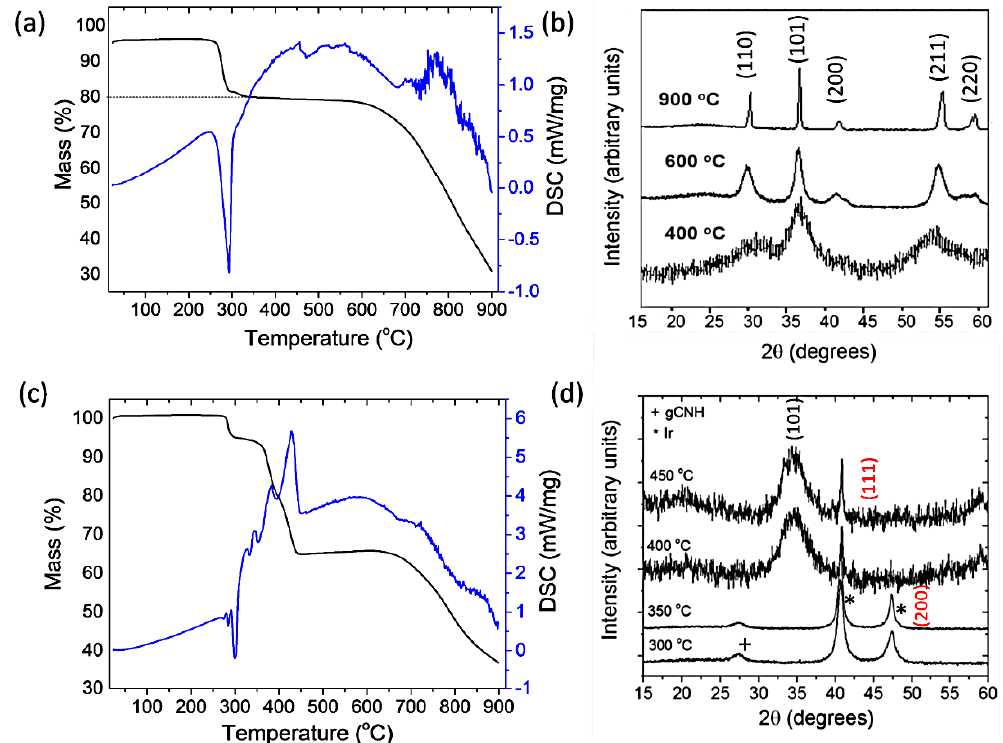
Figure 2. ( a ) TGA/DSC of the reaction between (NH 4 )Ir 2 Cl 6 and NaNO 3 conducted in air at a 5 ◦ C min − 1 heating rate; ( b ) the XRD of the IrO 2 NPs produced at 400, 600, and 900 ◦ C by the Adams’ fusion method; ( c ) the TGA/DSC of (NH 4 )Ir 2 Cl 6 , NaNO 3 , and gCNH support conducted in air at a 5 ◦ C min − 1 heating rate; ( d ) XRD of the gCNH-IrO 2 prepared at 300, 350, 400, and 450 ◦ C. Note: the NaCl formed in the reaction was washed out prior to the XRD acquisition. The weak feature for gCNH occurs at ~27 ◦ 2 θ . The characteristic strong (111) and (200) reflections for metallic Ir are indexed in red.